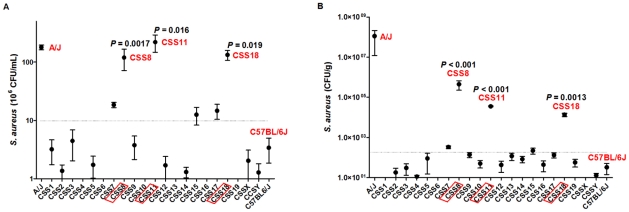
Bacterial load in peritoneal fluid and kidneys is higher in chromosome substituted strain (CSS) 8, CSS11 and CSS18 mice after S. aureus injection.(A) Bacterial load in peritoneal fluid. C57BL/6J, A/J, and CSS mice were injected (i.p.) with Sanger 476 (107 CFU/g) and euthanized 24 h later (n = 5 mice for each murine strain). (B) Bacterial load in kidneys. C57BL/6J, A/J, and CSS mice were injected (i.p.) with Sanger 476 (107 CFU/g) and euthanized 24 h later (n = 5 mice for each murine strain). P-values were calculated from the F-test. Values of P<0.05 were considered significant.